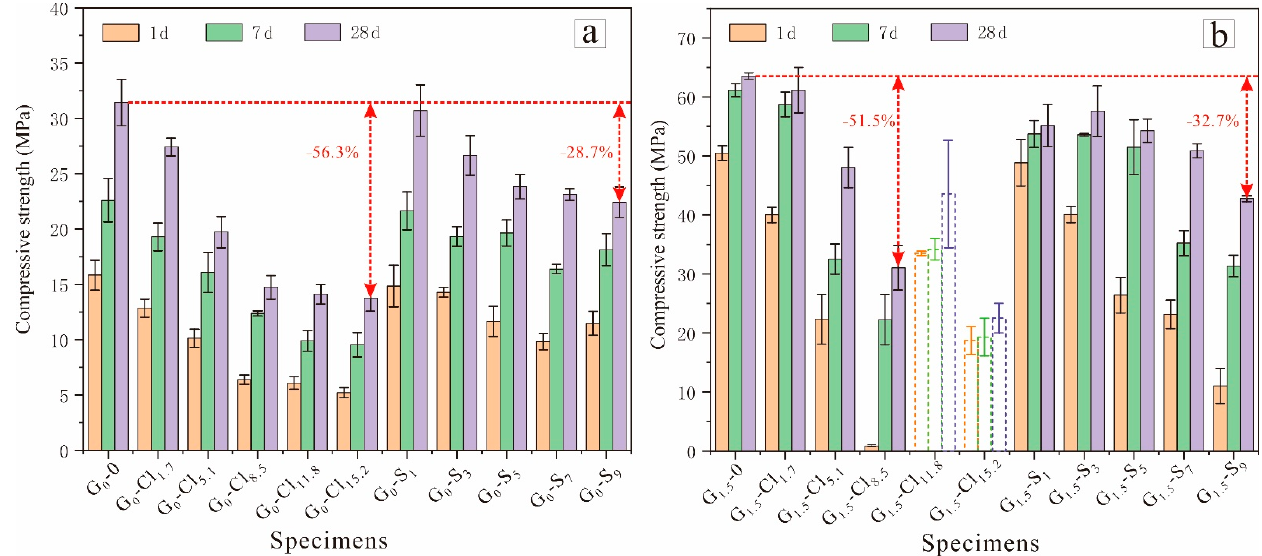
Figure 4. Compressive strengths of ( a ) NaOH-activated and ( b ) Na 2 SiO 3 -activated geopolymers (dotted lines indicate specimens cured at 40 °C).